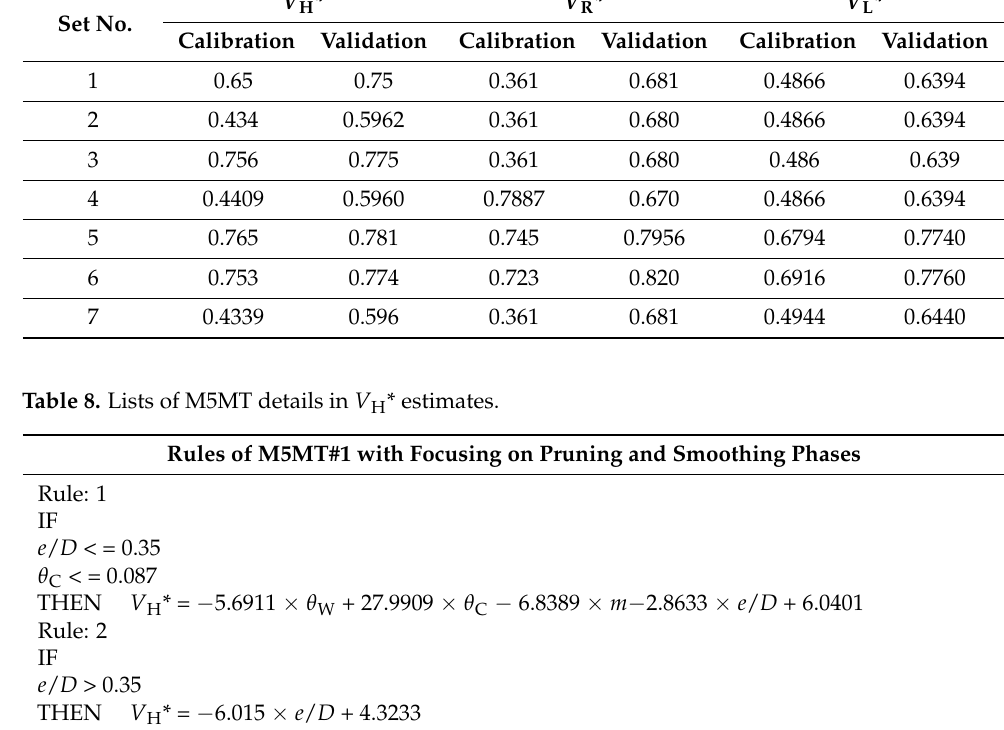
Table 7. Correlations of M5MT performance in the calibration and validation stage for 3D scour rates. Set No.